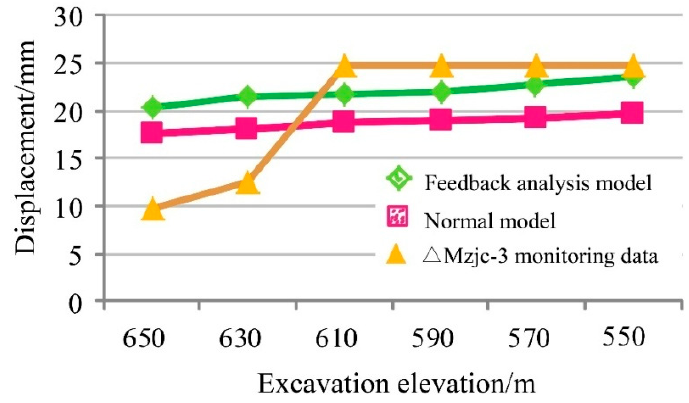
Figure 15. Deformation comparison of the rock slope using different approaches during excavation